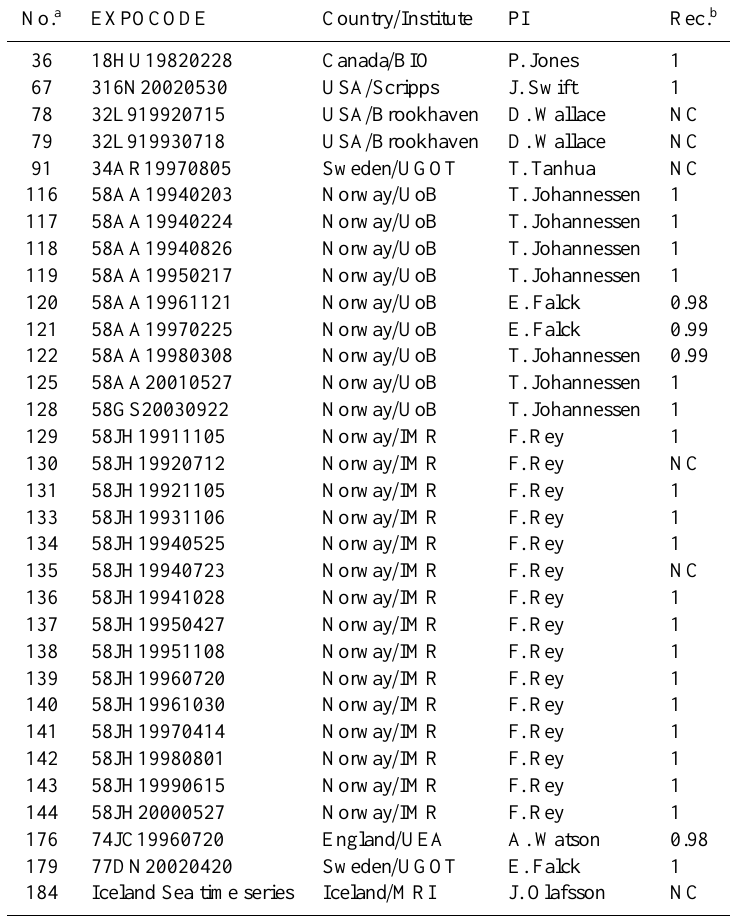
Table 1. CARINA cruises with dissolved oxygen data in the Nordic Seas. No. a EXPOCODE Country / Institute PI Rec.